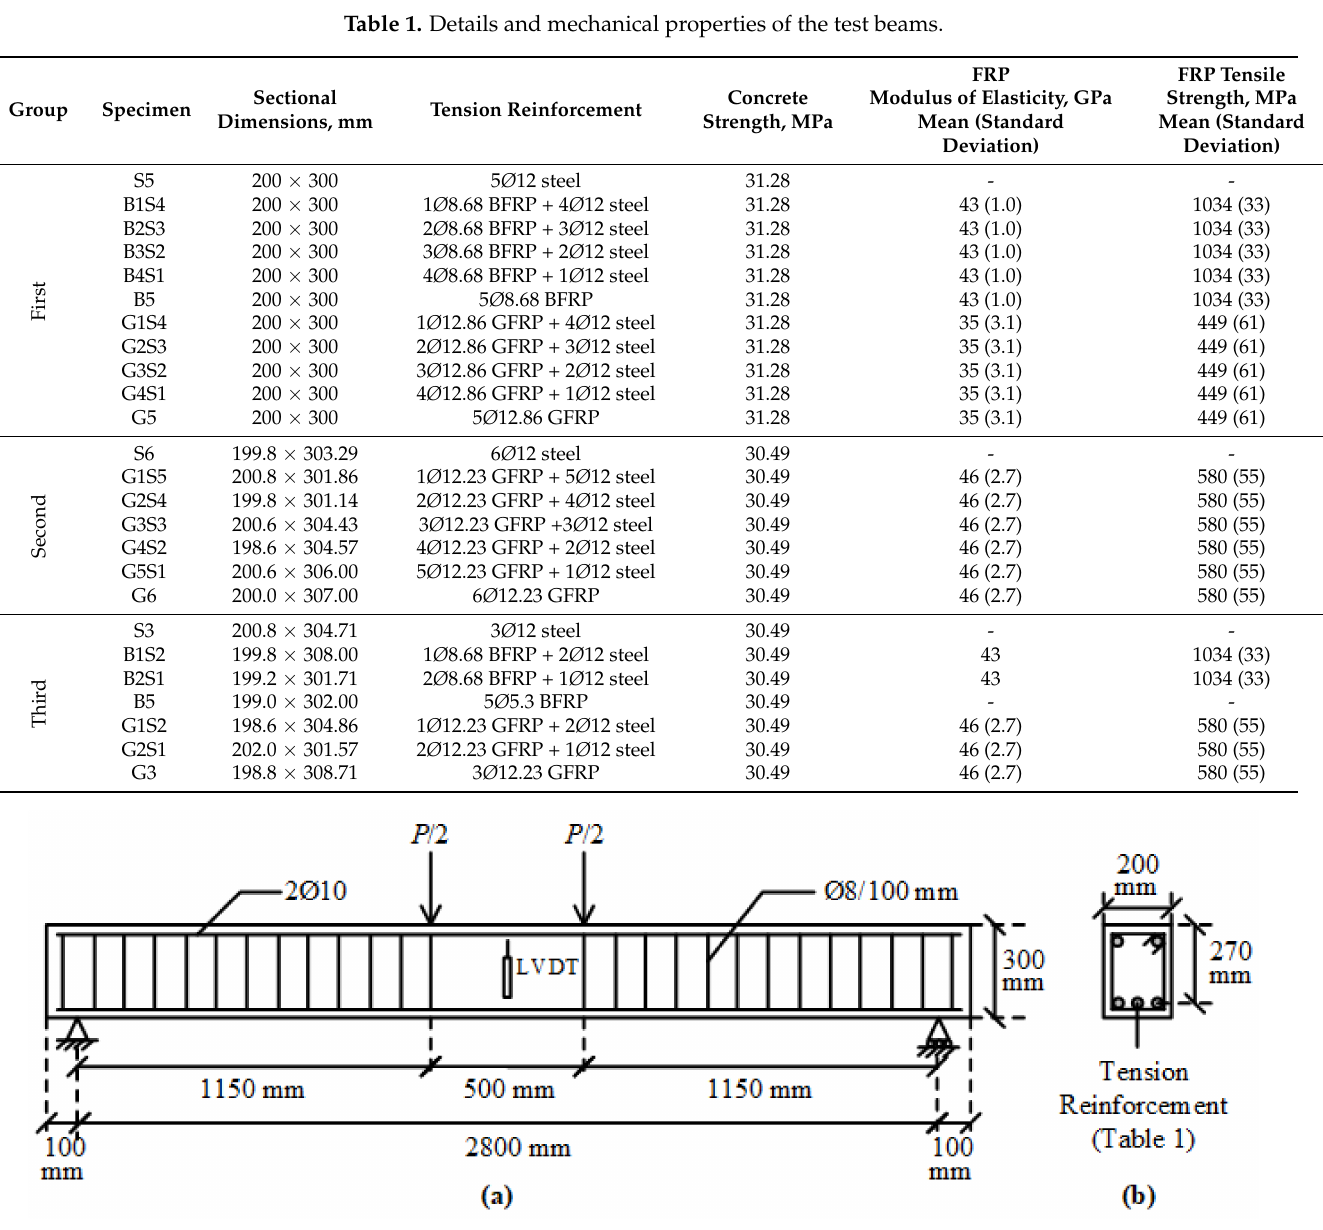
Figure 1. Reinforcement details and dimensions of the test beams. ( a ) Elevation and ( b ) cross-section. The first group of beams was designed as over-reinforced in terms of FRP reinforce- ment. In other words, concrete crushing preceded the rupture of FRP bars, yet occurred after the yielding of steel bars. All of the beams in this group contained a total of five tension bars. Two types of FRP bars, namely BFRP and GFRP, were used in the first set alongside steel bars. The second set of beams, in contrast, were reinforced with six tension bars of two types (GFRP and steel). This group was designed again as over-reinforced. The third group had only a total of three tension bars of three types (BFRP, GFRP, and steel) to provide an under-reinforced beam design, i.e., a tension-controlled mode of failure. In this type of failure, FRP rupture takes place before the concrete crushing, yet occurred after the yielding of steel bars. Specimen B5 in the last group contained five BFRP bars, unlike the remaining beams in the group, considering the manufacturer could not provide a sufficient number of bars with a 8.68-mm diameter. For this reason, a beam with five Ø5.3 bars and with the same tensile reinforcement area as the three Ø8.68 bars was constructed as the reference